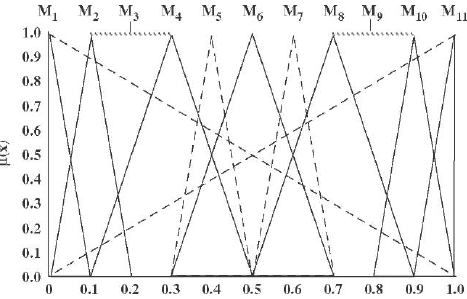
Fig. 3. Linguistic terms into their corresponding fuzzy (Jain & Raj, 2013) Conversion of linguistic terms into fuzzy scores (11-point scale) (Jain & Raj, 2013c) Linguistic term Fuzzy no. Crisp no. Exceptionally low Extremely low